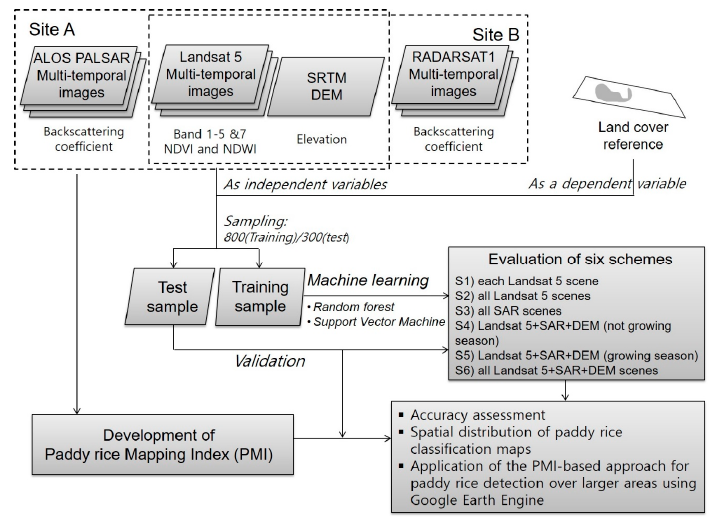
Figure 3. Process flow chart of this study.